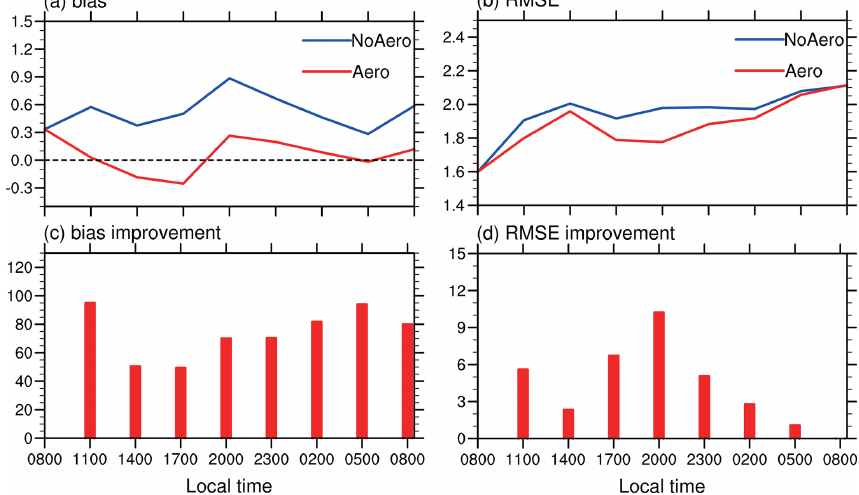
Figure 12. Area-averaged (a) bias and (b) RMSE of simulated 2m temperature ( ◦ C) in NoAero (blue) and Aero (red) over NCP area (defined in Fig. 1a), averaged from 6 to 10 December 2015, and the mean improvement (%) of (c) the absolute value of bias and (d) RMSE in Aero relative to